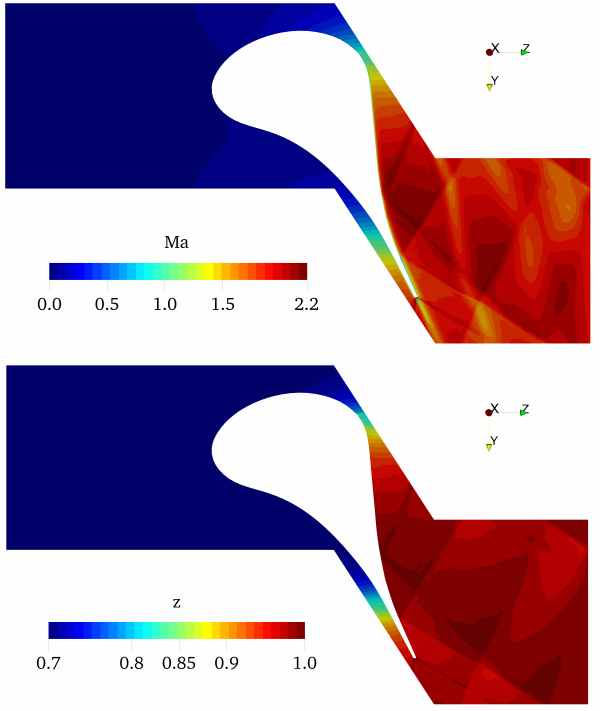
Figure 5. ORC nozzle. Mach number ( top ) and compressibility factor ( bottom ) contours, P 2 solution. Distorted geometries are depicted because the blade design is confidential property of the manufacturer.